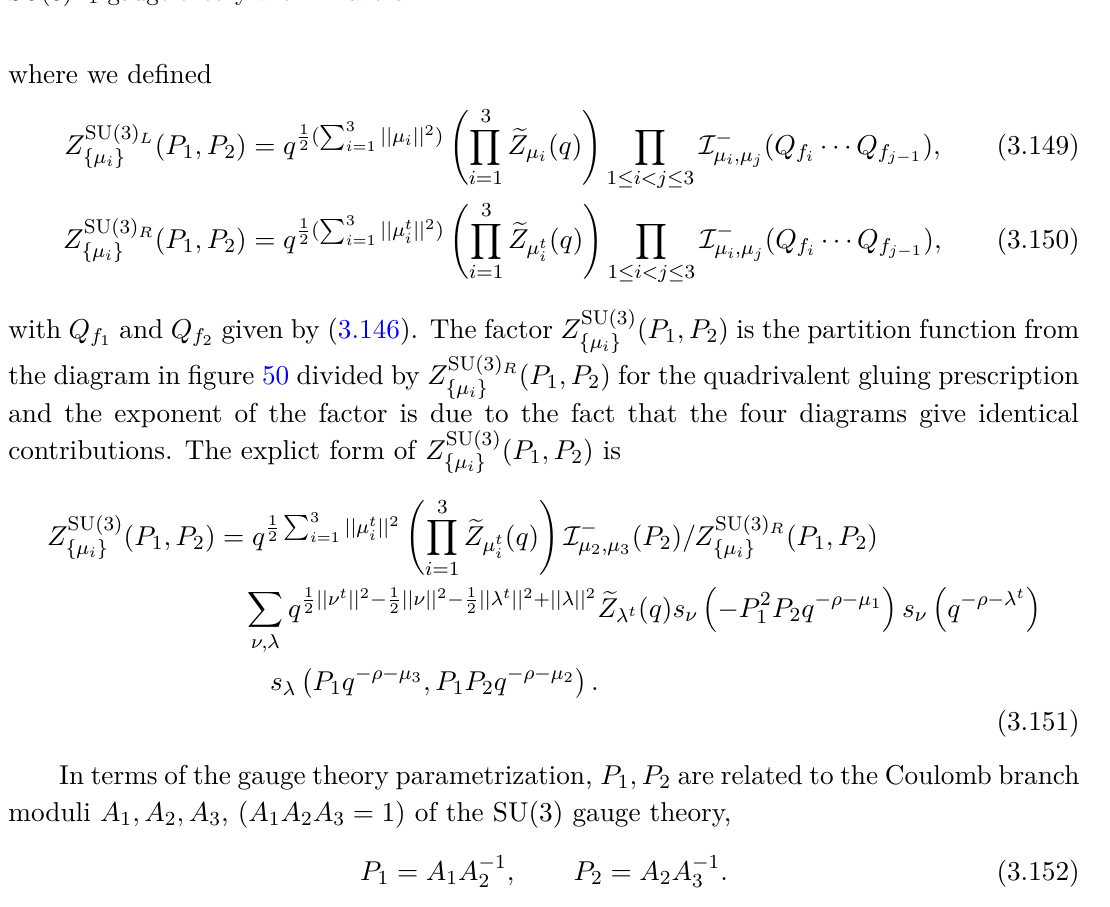
Figure 51. (a). The local diagram for one of the four parts which form the quadrivalent SU(3) gauging. i runs from 1 to 4 representing the four parts. (b). The local diagram which describes the SU(3) − 1 gauge theory with 4